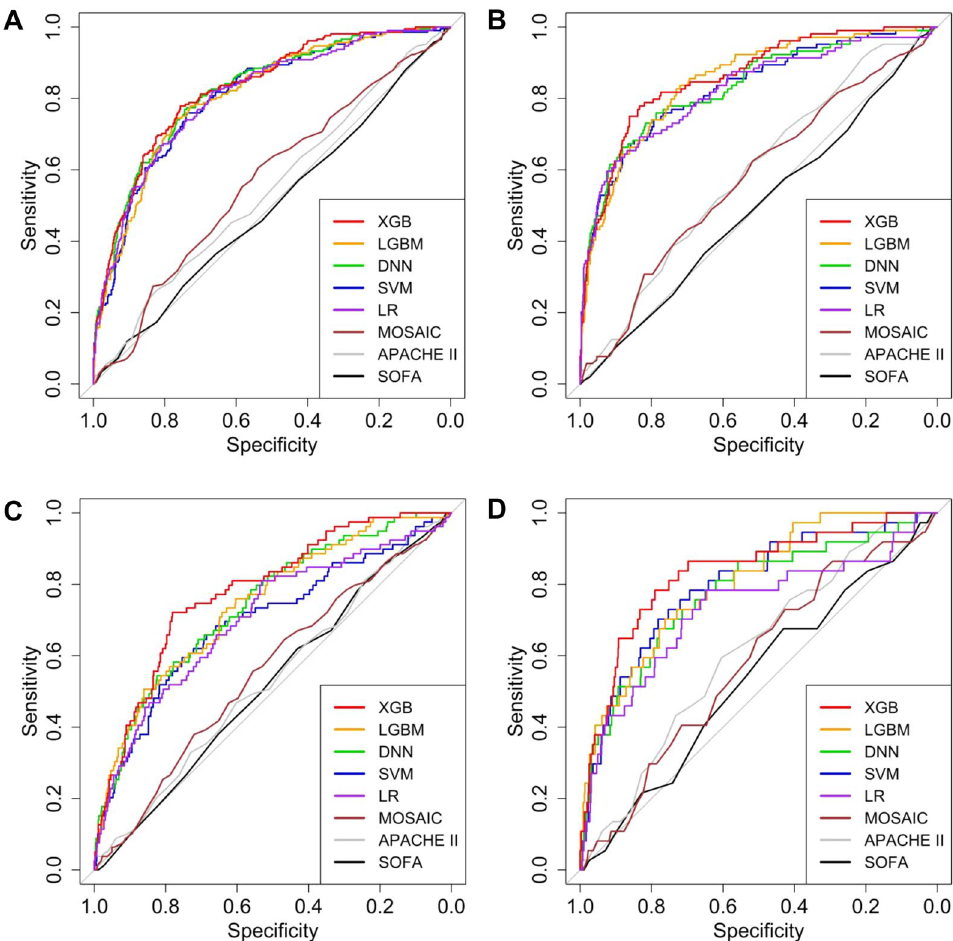
Figure 1. Receiver operating characteristic curves of models in predicting a reduction in mean arterial pressure ≥ 20 mmHg ( A , C ) and ≥ 30 mmHg ( B , D ) within 6 h ( A , B ) and 1 h ( C , D